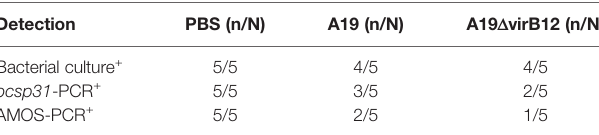
TABLE 1 | The effect of vaccine immunization on the elimination of virulent Brucella .